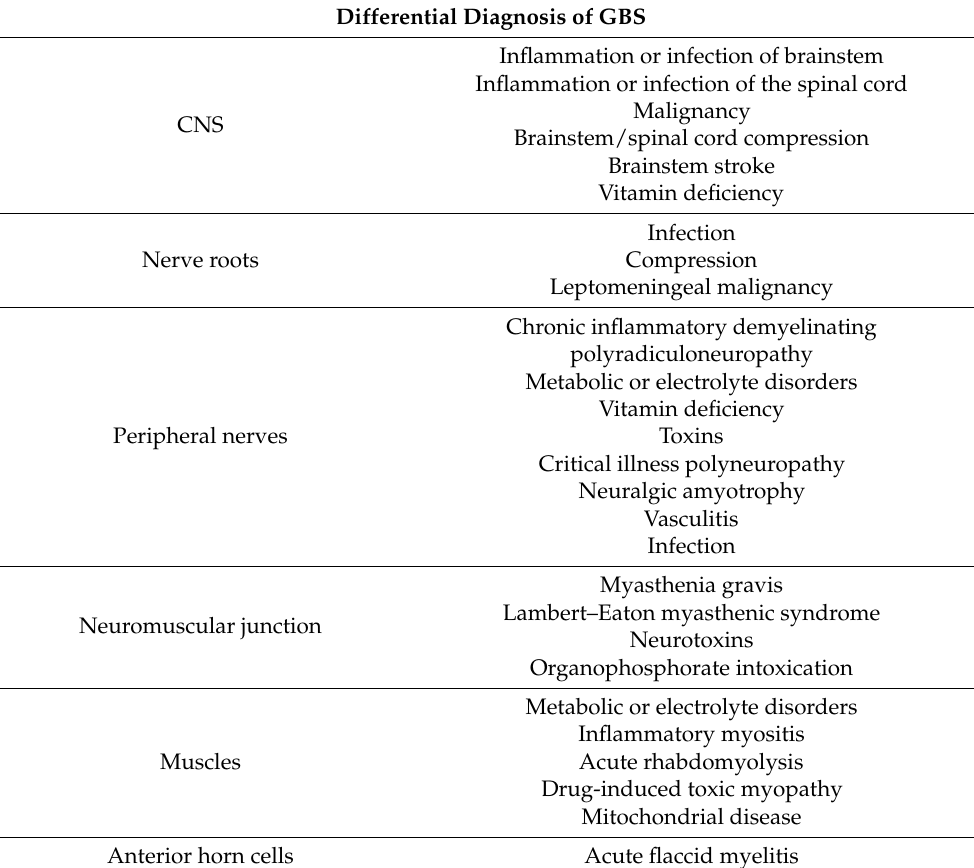
Table 3. Differential diagnosis of